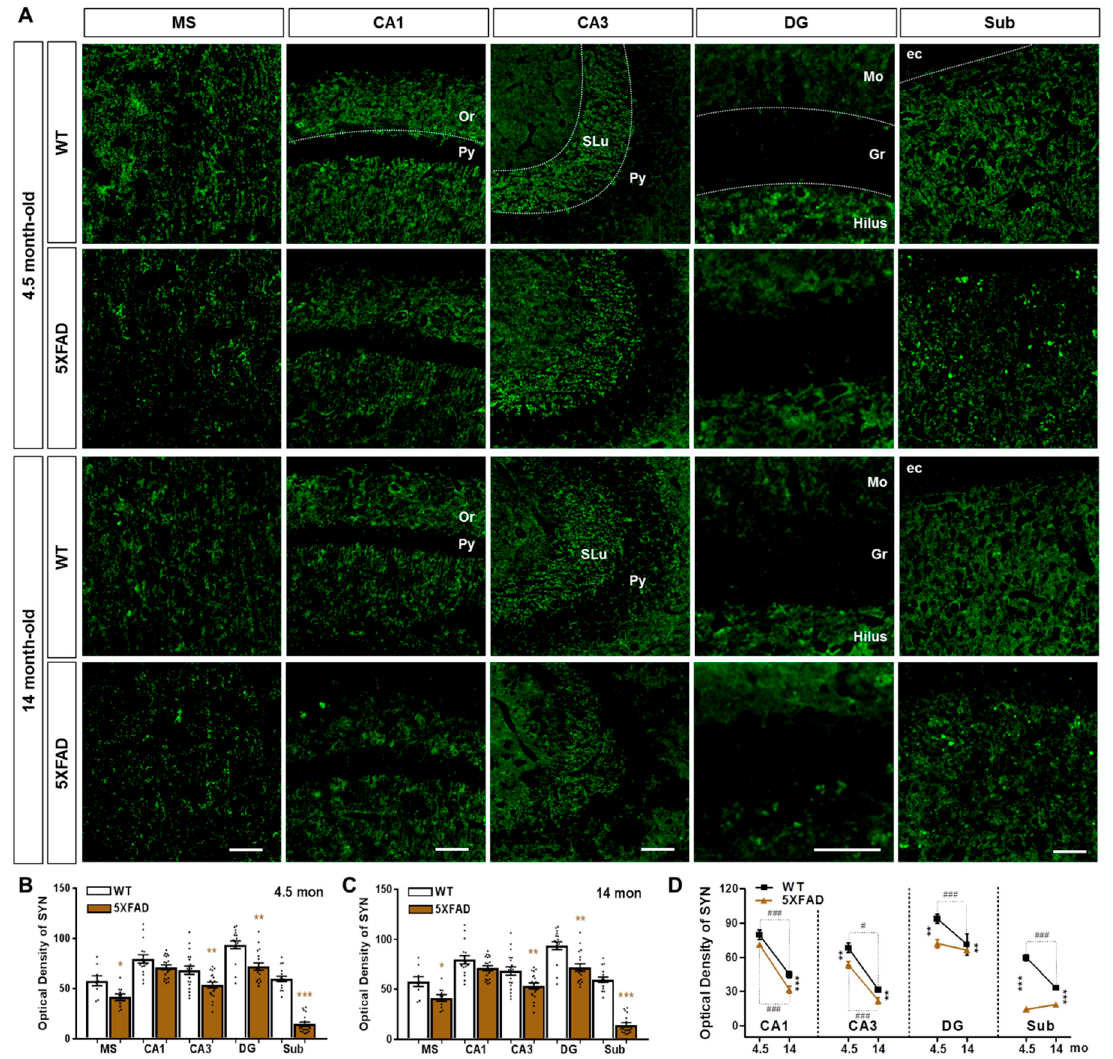
Figure 3. Synaptic degeneration in the hippocampal formation and MS of 5XFAD mice. ( A ) Pre-synaptic terminals were visualized using anti-synaptophysin (SYN) antibody in MS and the hippocampal formation of WT and 5XFAD mice at 4.5 and 14 months of age. ( B – D ) Fluorescence intensity of SYN immunoreactivity was quantified in the 4.5- and 14-month-old WT and 5XFAD mice. Scale bar = 100 μ m. * p < 0.05, ** p < 0.01, and *** p < 0.001 indicate significant differences between the groups. # p < 0.05, and ### p < 0.001 indicate significant differences between the different ages in the same group (n = 20–35 images/group).